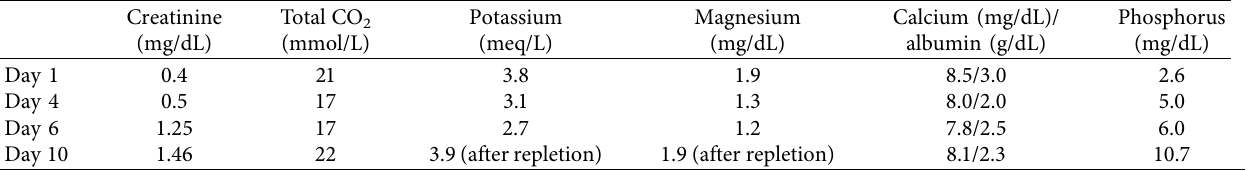
Table 1: Patient’s laboratory